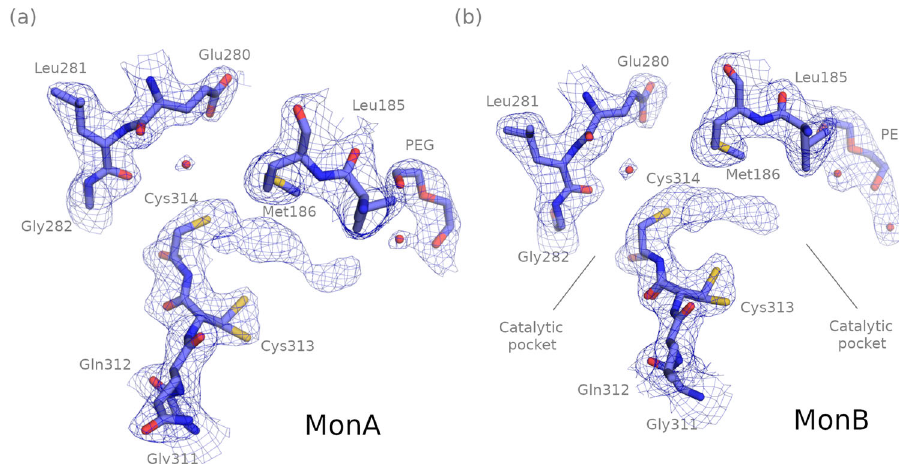
Fig. 2 The apo ALDH1A3 crystal structure (PDB code 7QK7). 2Fo – Fc electron density map at σ = 1 and fi tted crystal structure of the apo form of monomer A ( a ) and B ( b ) of ALDH1A3 close to the NAD + -binding and substrate-binding